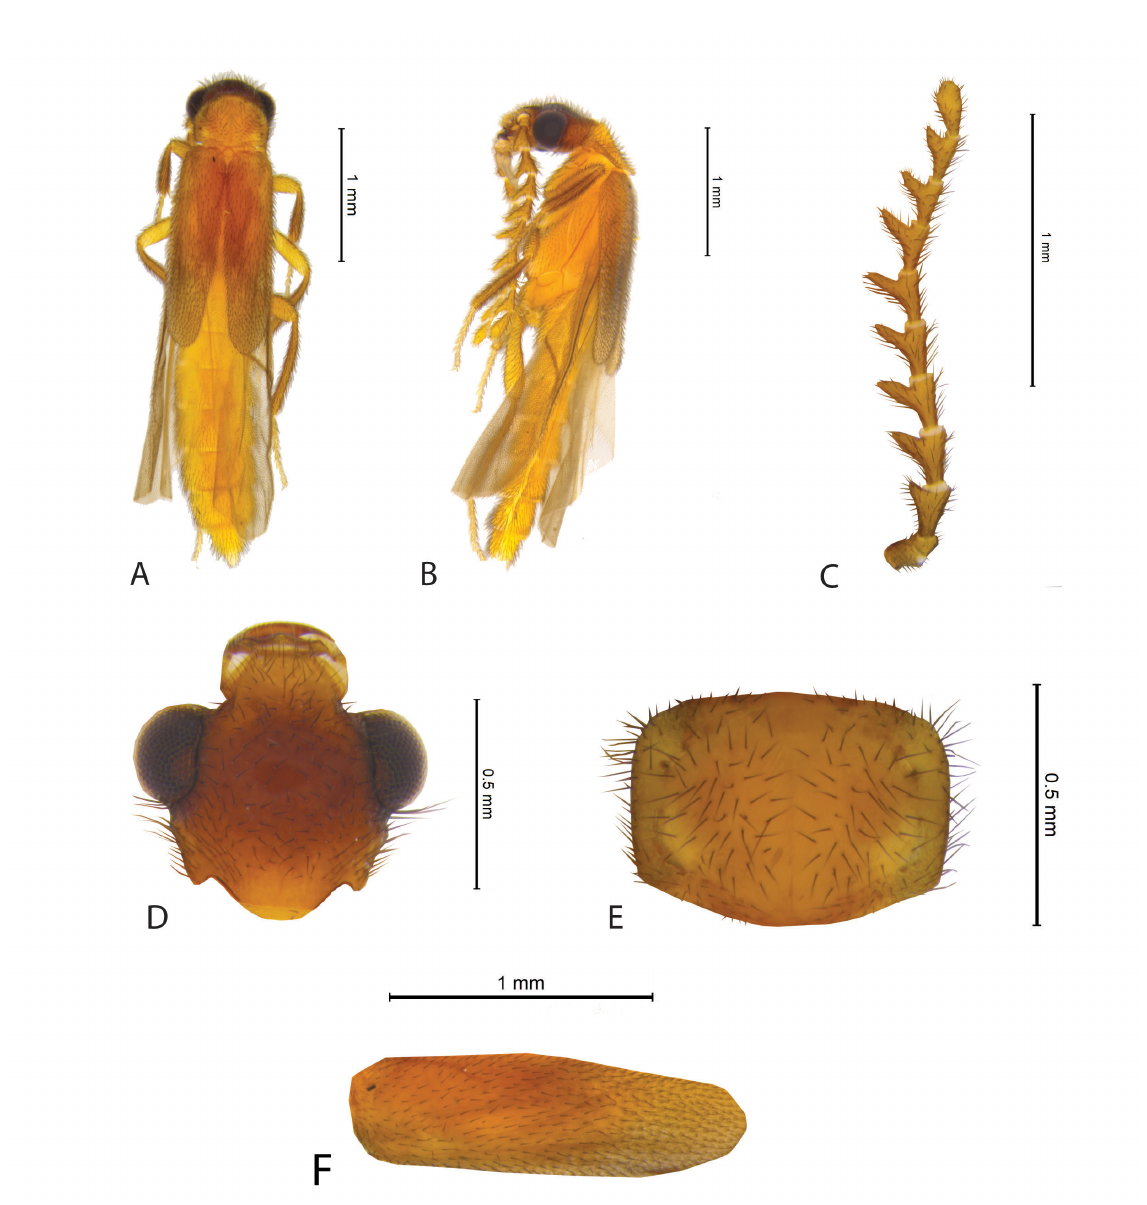
Fig. 1. Pseudotelegeusis meloi sp. nov., paratype from Mazuko DZUP 458.569. A . Habitus, dorsal view; B . Habitus, lateral view. C . Antenna, lateral view. D . Head, dorsal view. E . Pronotum, dorsal view. F . Left elytron, dorsal